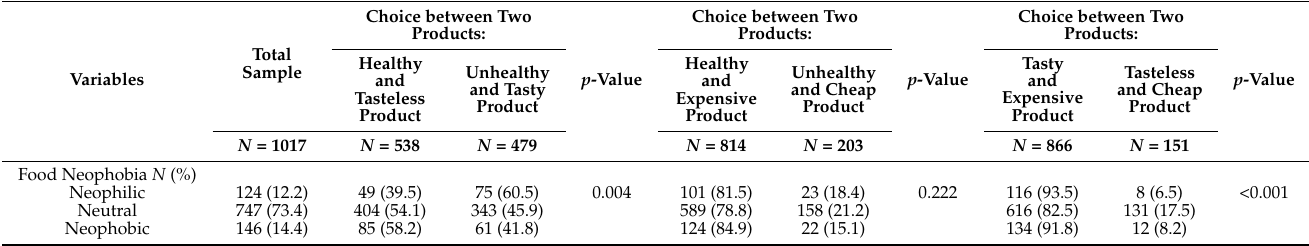
Choice between Two Products: